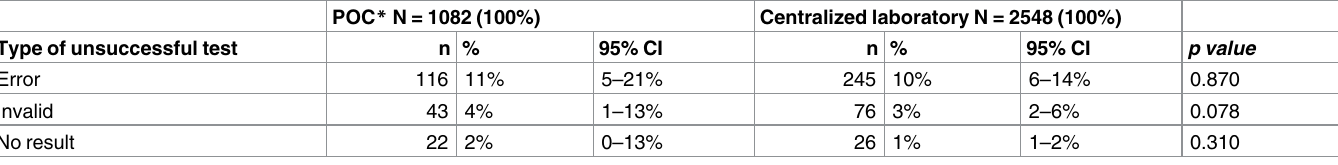
Table 2. Type of unsuccessful tests by Xpert testing sites.